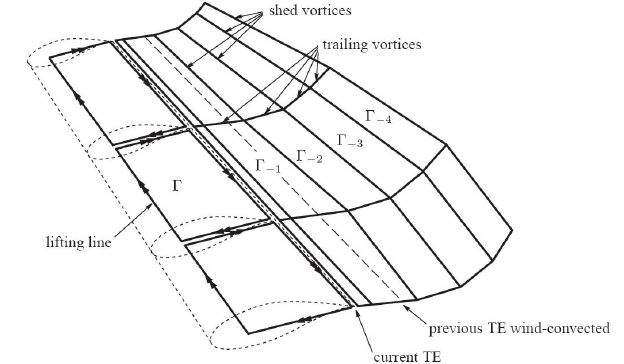
Figure 4. AWSM wake geometry (van Garrel,